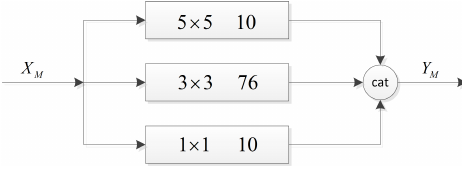
Figure 2. The architecture of MFEBlk.